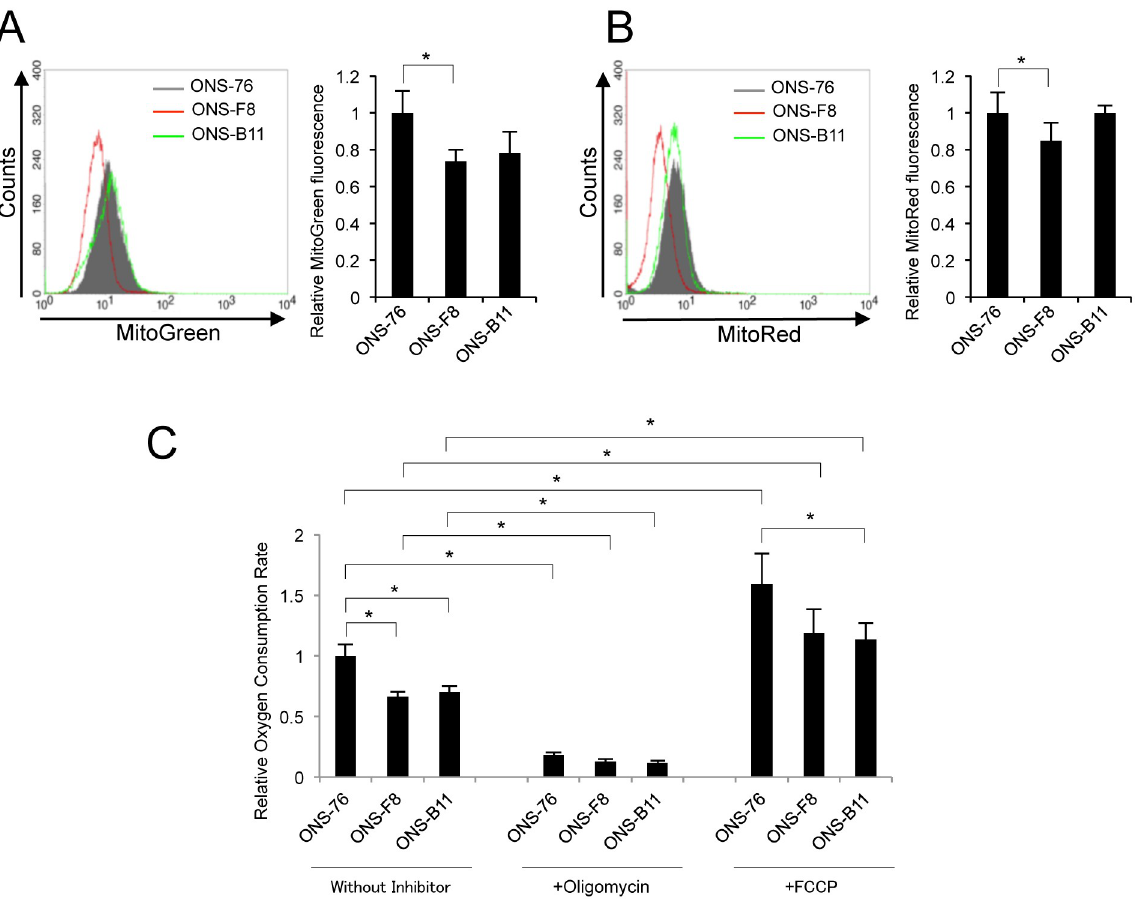
Fig 2. Diminution of mitochondrial respiration in ONS-F8 and -B11. (A) Mitochondria mass, (B) mitochondria membrane potential, (C) OCR (using MitoXpress) in ONS-76, -F8 and -B11 cells. All quantitative data are means ± S.D. * P < 0.05,Welch’s t-test.